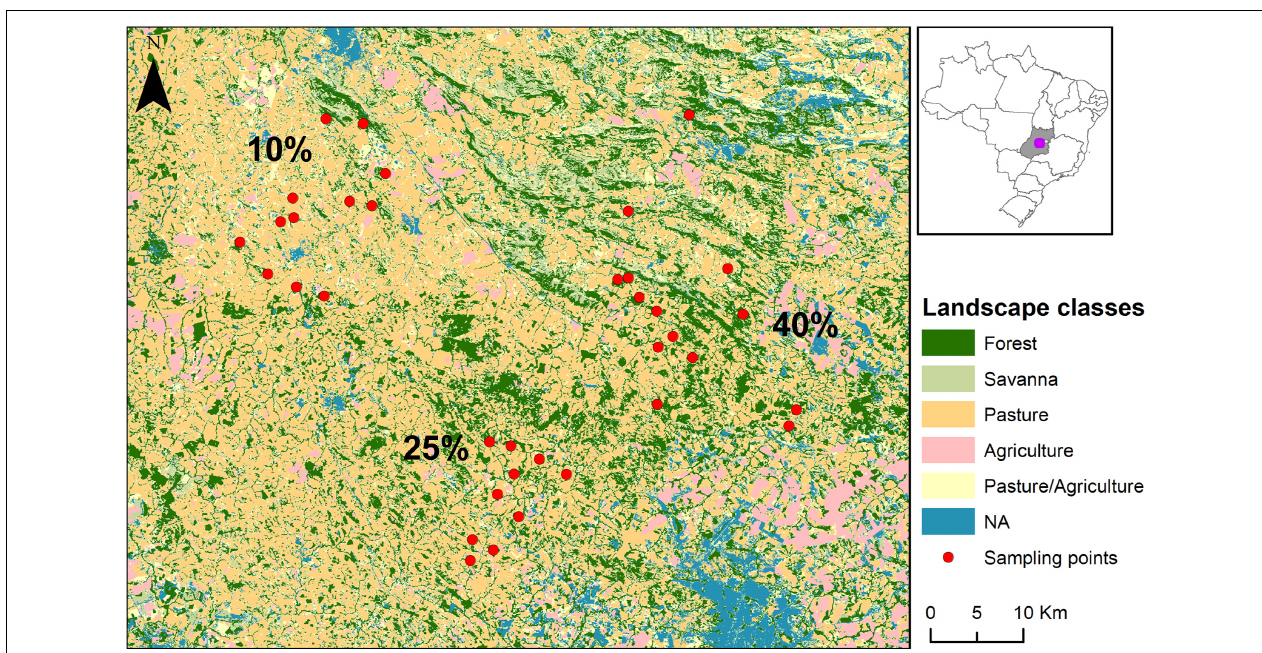
FIGURE 1 | Landscapes of 15,000 ha with 10, 25, and 40% of habitat amount (including both forest and savanna), and the sampled patches (red dots) in central state of Goiás, Brazil (highlighted in gray in the inset map). Patches located in the western portion of the map are within the landscape with 10% of remnant habitat amount; southern patches correspond to the landscape with 25%; and the eastern patches are in the landscape with 40% of habitat